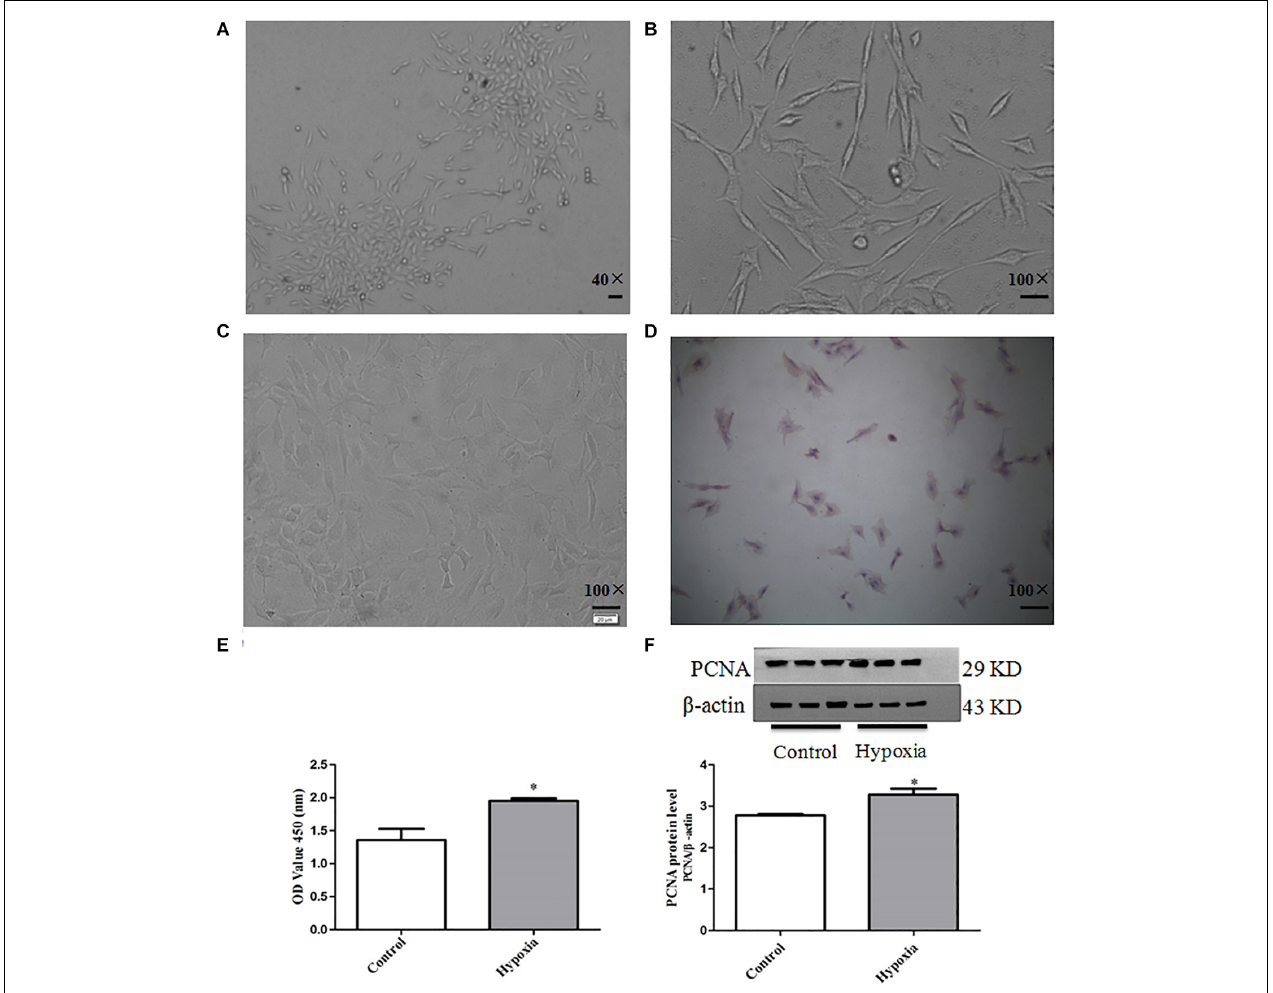
FIGURE 1 | The culture and identification of primary PASMCs and establishment of PASMC proliferation model. (A) Cell morphology of third passage (40 × ), scale bar = 40 mm. (B) Cell morphology of sixth passage (100 × ), scale bar = 100 mm. (C) Negative control (100 × ), scale bar = 100 mm. (D) α -Smooth muscle actin immunohistochemistry (100 × ), scale bar = 100 mm. (E) The cell viability of hypoxia-induced PASMC proliferation by CCK8 for 48 h. (F) The expression of proliferative marker protein PCNA in PASMCs for 48 h. Control: PASMCs were cultured in 37 ◦ C, 5% CO 2 incubator; hypoxia: 3% O 2 , PASMCs were cultured in small hypoxia chamber for 48 h. Data are mean ± SEM, n = 3. * P < 0.05 vs. control.